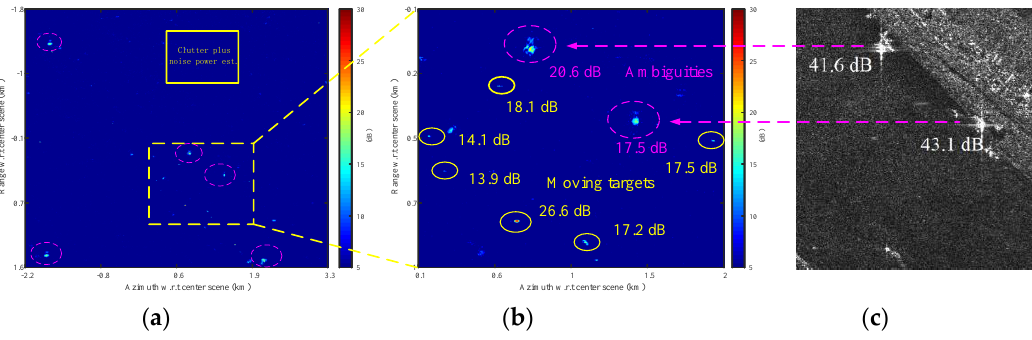
Figure 8. Signal-to-clutter-plus-noise ratio (SCNR) image using signal subspace projection (SSP) with a 2-by-2 magnitude multilook (The clutter-plus-noise power is estimated by averaging the pixels within the solid rectangle box in ( a )): ( a ) full scene; ( b ) magnified part of ( a ); and ( c ) objects that cause ambiguities in ( b ) (the image chip is taken from the lower right part of Figure 1).